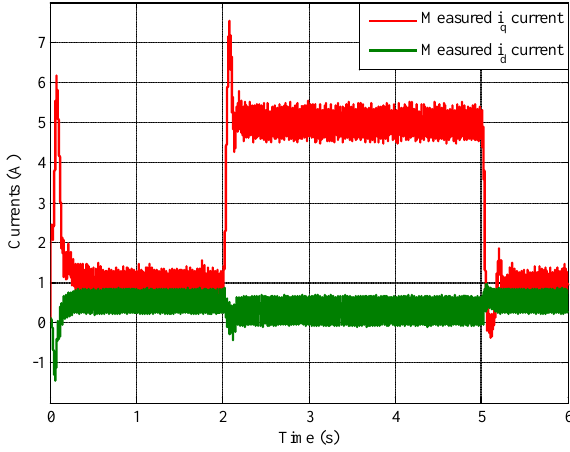
and under SFBK control. i q i d